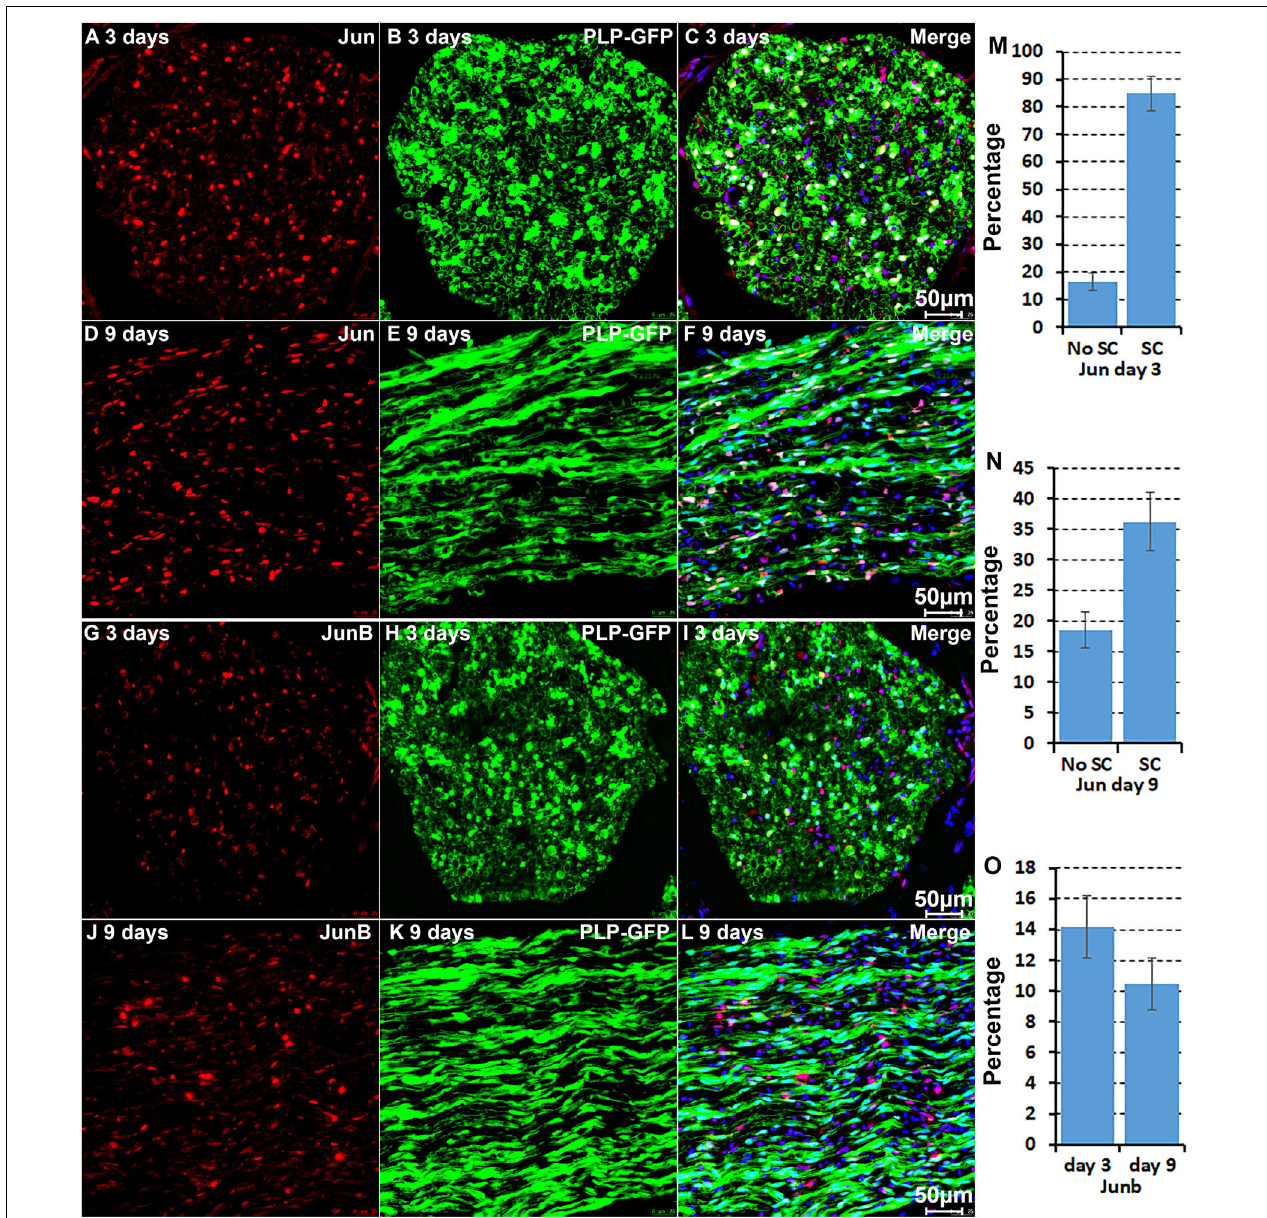
FIGURE 5 | Immunostaining validates Jun and Junb expression in cells of the distal nerve stump. (A–C) Jun is primarily expressed in Schwann cells of the distal nerve at day 3 post-injury. (D–F) Jun expression in cells of the distal nerve at day 9 post-injury. (G–I) Junb expression in GFP negative cells of the distal nerve at day 3 post-injury. (J–L) Junb expression in GFP negative cells of the distal nerve at day 9 post-injury. (M,N) Quantification of Jun expressing in Schwann cells against the total number of Schwann cells in the distal nerve stump at day 3 and day 9 post-injury. (O) Quantification of Junb expressing cells against the total number of GFP negative cells in the distal nerve stump. For all panels, sections of distal nerve following injury were prepared from PLP-GFP transgenic mice that label Schwann cells with GFP. Scale bars in C, F, I, and L: 50 µ m. Quantification data in (M–O) was shown as Mean ± SEM, n =